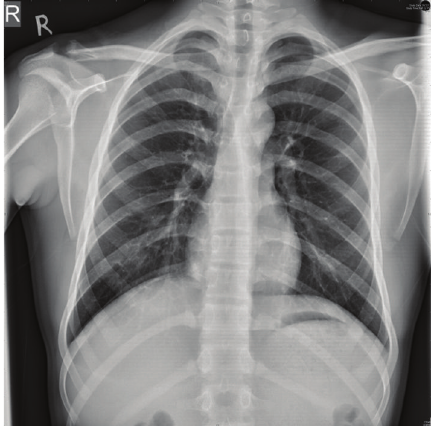
Figure 4: Follow-up radiograph at 18 months showing union at the lateral end of the clavicle and persistent sternoclavicular